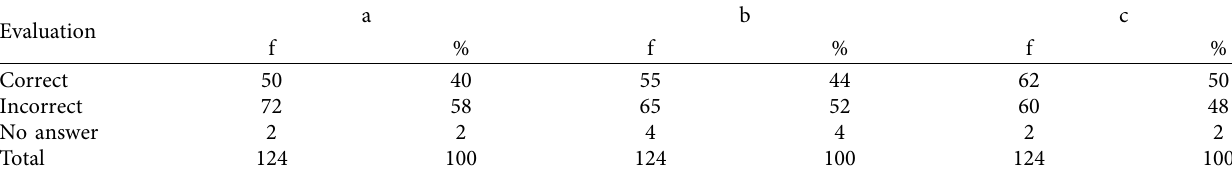
Figure 5: Question 5. Table 10: Distribution of students’ answer to question 5.